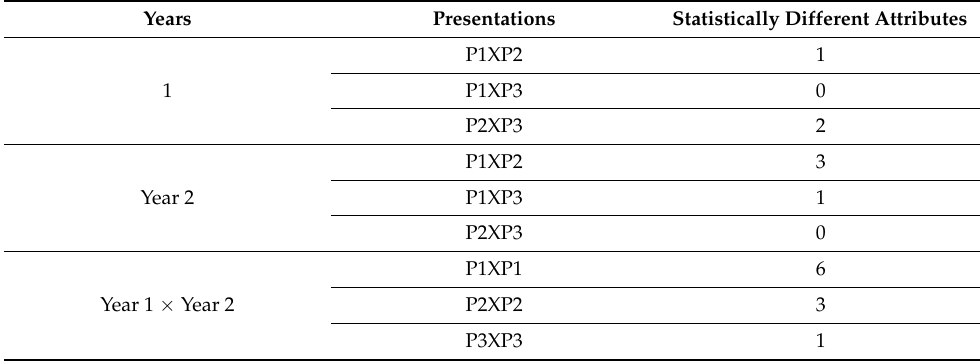
Table 4. Inferential tests between